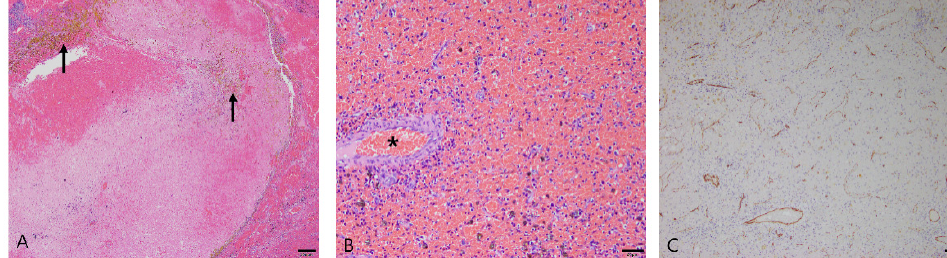
Figure 2. Hematoma in the spleen of dog. ( A ) Splenic mass formed by blood accumulation had yellow hematoidin crystals (arrows). Hematoxylin and eosin (H&E) at 40× magnification. Scale bar = 200 µm. ( B ) The cell population of the mass consisted mostly of red blood cells. Vascular endothelial cells formed a single layer (asterisk). H&E at 200× magnification. Scale bar = 50 µm. ( C ) Immunohistochemical staining for CD31 with Mayer’s hematoxylin counterstain. CD31 expression was only observed in a layer of normal endothelial cells. 100× magnification. Scale bar = 100 µm .